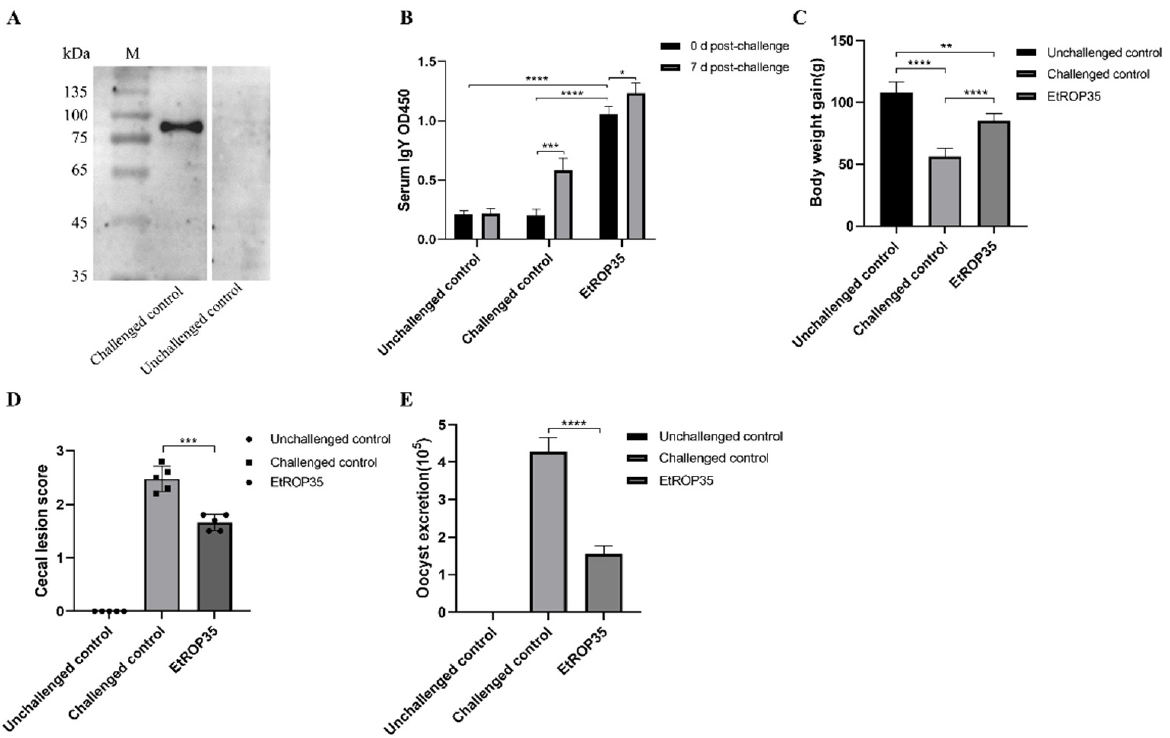
Figure 5. Immune protection induced by EtROP35. ( A )The recombinant EtROP35 recognized by chicken serum. ( B ) Levels of serum IgY (OD450). ( C ) Mean body weight gain. ( D ) Cecum lesion score. ( E ) The number of oocysts excreted per gram (7dpi to 9dpi). Data are present as mean ±SD of three independent experiments and determined by t -tests. Significant difference: * p < 0.05, ** p < 0.01, *** p < 0.001, **** p < 0.0001.